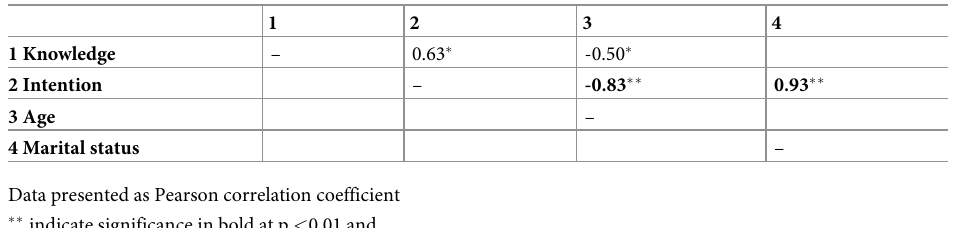
Table 3. Correlations between knowledge, intentions, age, and marital status.